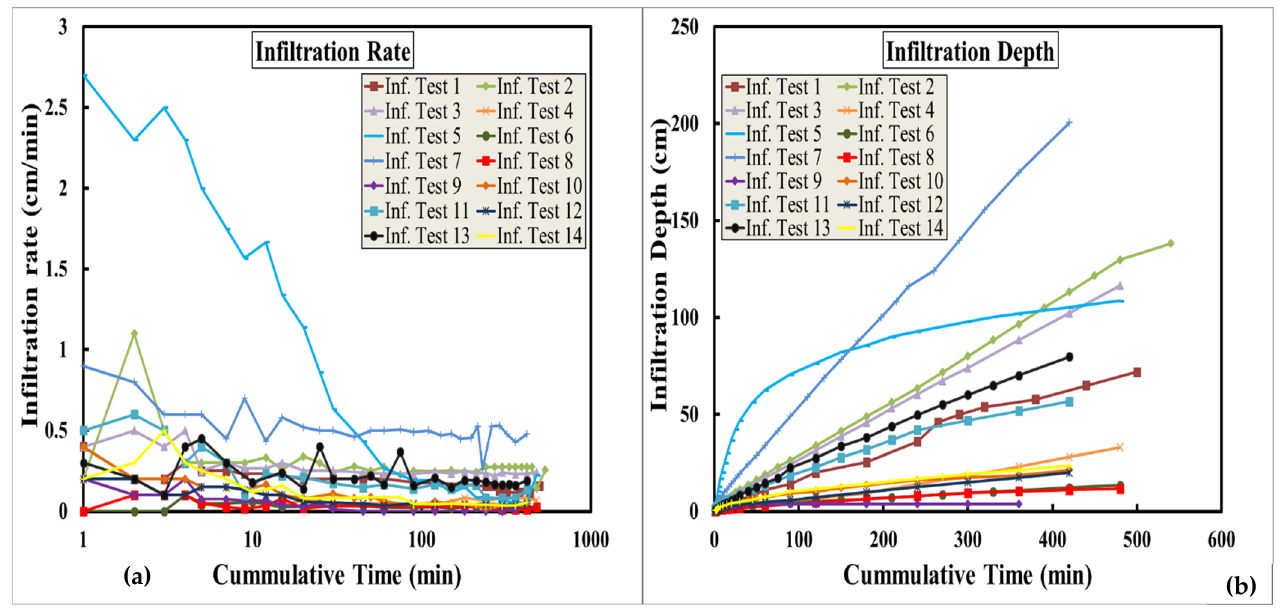
Figure 6. Field-measured infiltration tests: infiltration rates ( a ) and cumulative infiltration depths ( b ) versus